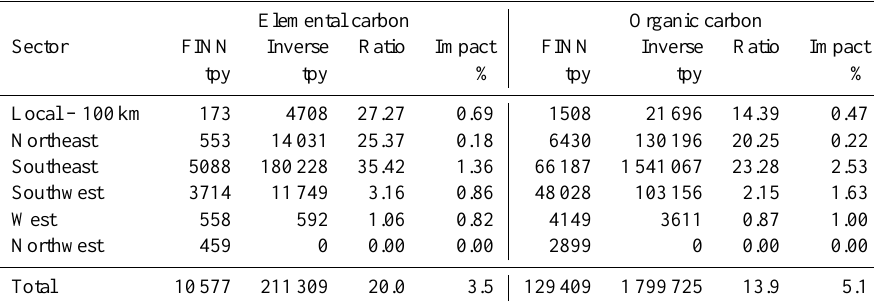
Figure 3. Open burning emissions of EC and OC for the Large domain for 2002 using the FINN model, which include forest, prescribed and agricultural fires detected by Terra MODIS. Pink lines show the six sectors used in the inverse model, pink dot is the supersite. Table 2. Emission totals for open burning by geographical sector relative to the measurement site for the FINN model and the least squares inverse model. Also shown are the ratios of the inverse emission estimates to the FINN prior estimates and the fraction of EC or OC at the measurement site that is estimated to be due to open burning. Note that OC Inverse totals combine primary emissions and secondary formation. Elemental carbon Organic